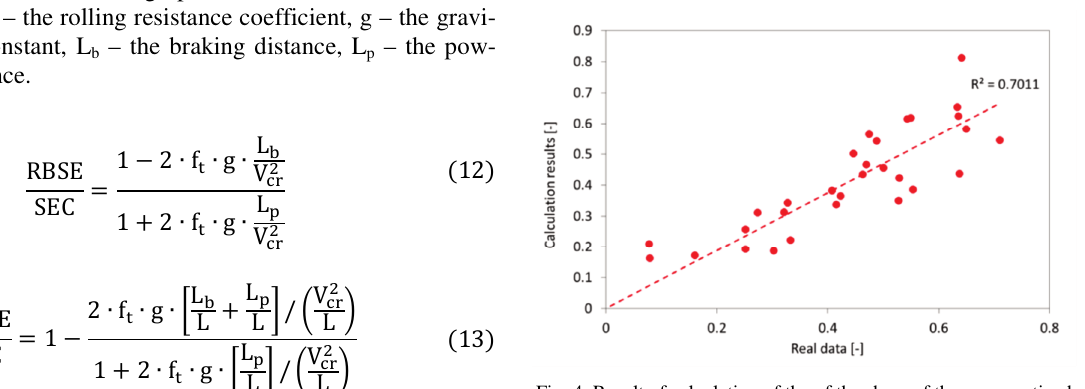
Fig. 4. Result of calculation of the of the share of the regenerative braking specific energy using equation (18) vs. the real traffic